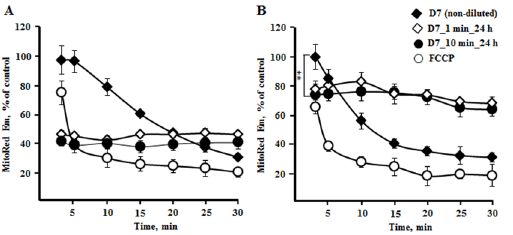
Fig 3. Effect of non-thermal plasma treatment on mitochondria membrane potential. The continuous exposure of cells to plasma treated PBS without it further dilution with medium results in a decay of mitochondria energization ( D7, black rhombi) similarly to what was observed in the presence of protonophore ( FCCP, empty circle). Decline in mitochondria energization in normal cells ( B, black rhombi) was faster than in cancer cells ( A, black rhombi), which are more resistant to plasma induced modulations. Samples D7_1 min_24 h (white rhombi) and D7_10 min_24 h (black circle) are the cells harvested after 24 h of incubation in the growth medium after being exposed to plasma D7 for 1 and 10 minutes. The normal cells restore their the membrane potential up to 70% within 24 h after treatment, while in the cancer cells the membrane potential remained at about 40% only (white rhombi and black circles). Data presented as mean ± SEM (n =